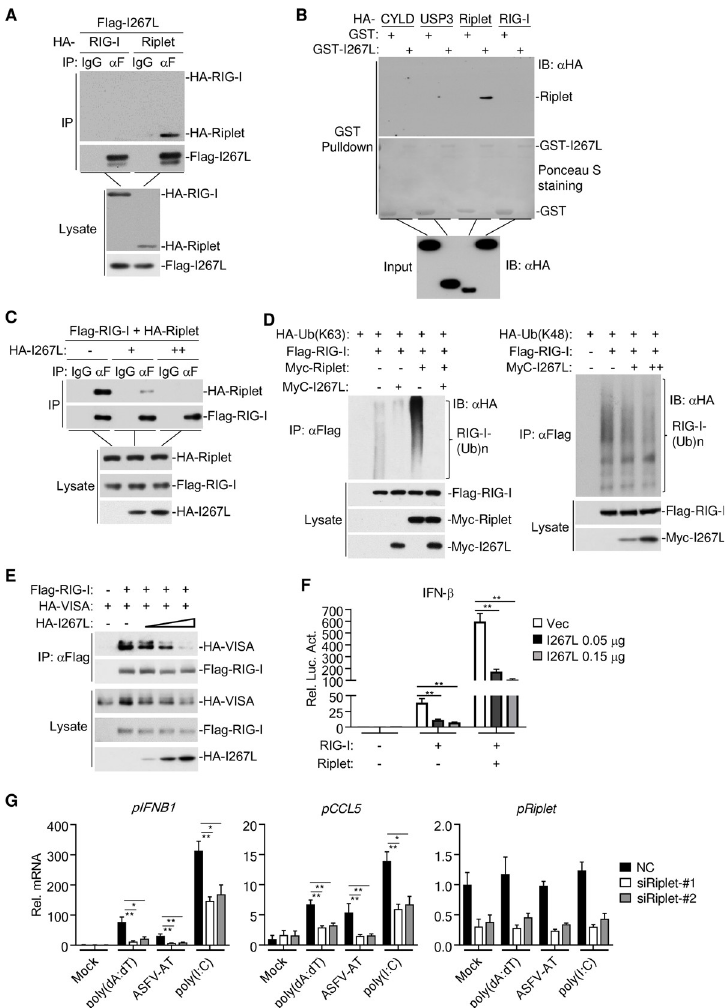
Fig 4. ASFV I267L targets Riplet. ( A ) HEK293T cells (5 × 10 6 ) were co-transfected with Flag-tagged I267L (5 μ g) and HA-tagged RIG-I (5 μ g) or HA-tagged Riplet (5 μ g). Coimmunoprecipitation and immunoblotting were performed with the indicated antibodies. ( B ) HEK293T cells (5 × 10 6 ) were transfected with the indicated plasmids (5 μ g). Twenty- four hours later, cell lysates were subjected to pull-down assay with in vitro purified GST or GST-I267L. ( C ) HEK293T cells (5 × 10 6 ) were co-transfected with plasmids of Flag-RIG-I and HA-Riplet (5 μ g), and increasing dose plasmids of HA-I267L (0, 1.0, 5.0 μ g). Coimmunoprecipitation and immunoblotting were performed with the indicated antibodies. ( D ) HEK293T cells (5 × 10 6 ) were transfected with plasmids as indicated. Twenty-four hours later, coimmunoprecipitation and immunoblotting were performed with the indicated antibodies. ( E ) HEK293T cells (5 × 10 6 ) were transfected with plasmids of Flag-RIG-I and HA-VISA, and increasing dose plasmids of HA-I267L. Coimmunoprecipitation and immunoblotting were performed with the indicated antibodies. ( F ) HEK293T cells (1 × 10 5 ) were co-transfected with the IFN- β promoter reporter, expression plasmids and empty vectors or I267L expression plasmids (0.05 μ g) as indicated. ( G ) PK-15 cells (1 × 10 5 ) were transfected with control (NC) or Riplet- siRNA (50 nM). Forty-eight hours later, cells were stimulated with transfected poly(dA:dT), ASFV-AT, and poly(I:C) (1 μ g/ml) for 6 hours before RT-qPCR were